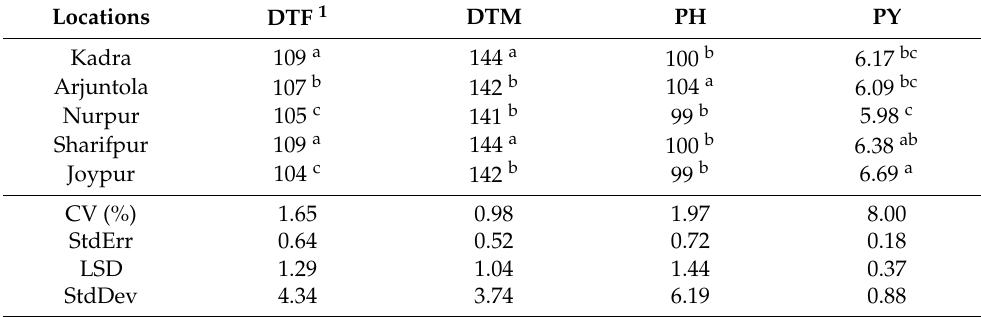
Table 3. Effect of location (environment) on the yield attributes and yield of rice